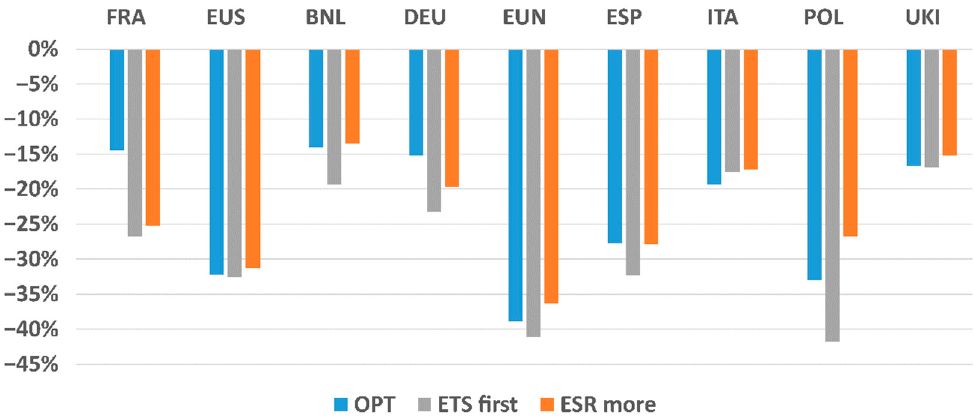
Figure 7. Reduction of CO 2 in 2030 compared to the reference scenario.